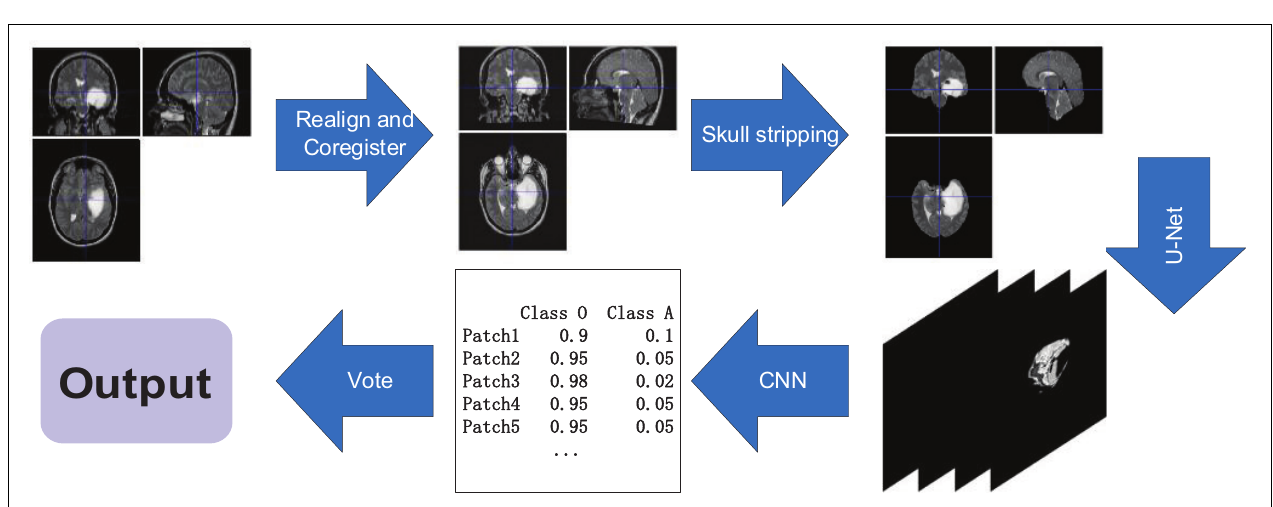
FIGURE 9 | The classification process of radiology images. The process aligns the images of different modalities through realignment and co-register, extracts brain tissue through skull stripping, extracts lesion area by the U-Net, and classifies cases by CNN.